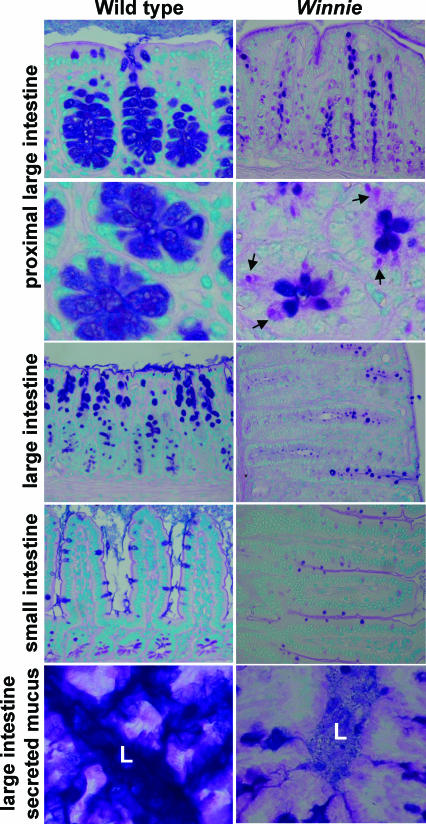
Histological Phenotype of Mice with Muc2 MutationsPAS/Alcian blue stained intestinal sections from Winnie and wild-type C57BL/6 mice. Note the reduced size of Alcian blue staining thecae (stored mucin) and the presence of PAS-positive/Alcian blue negative accumulations (arrows) in Winnie goblet cells. L, lumen.